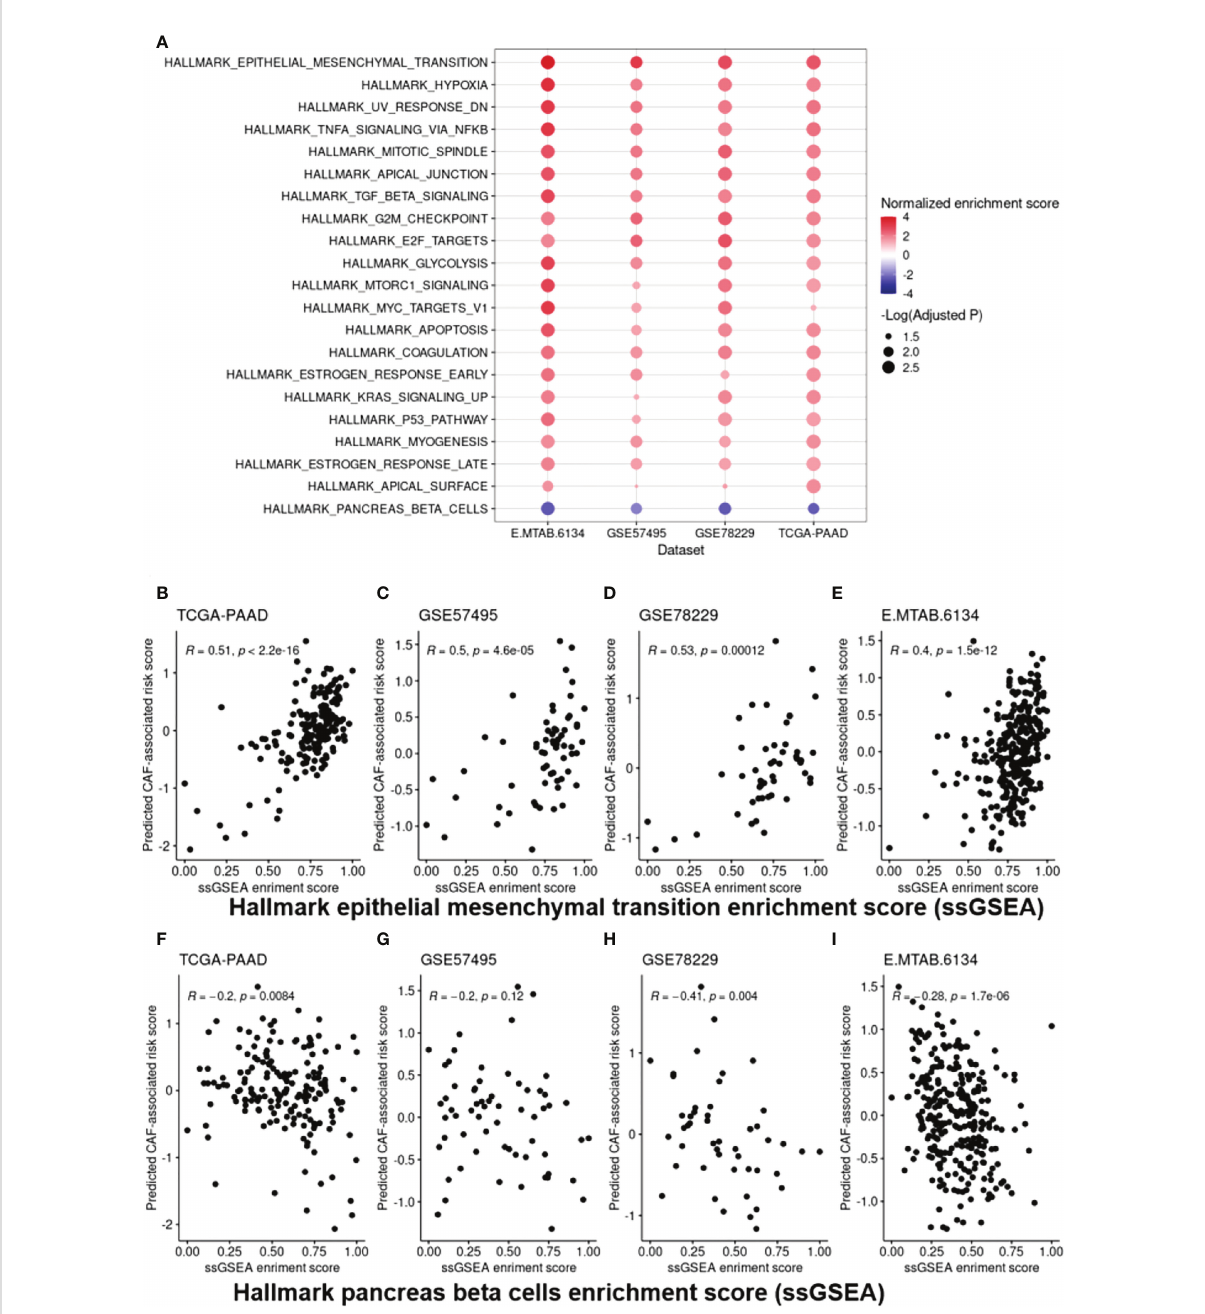
FIGURE 6 Cancer hallmark gene set analysis. (A) , EMT and “ pancreas beta cell ” gene sets were found to be the top dysregulated hallmark gene sets among all the studied datasets. (B-I) , Scatter plots representing the correlation of the CAF-associated risk model with ssGSEA enrichment scores for the EMT (B-E) and “ pancreas beta cell ” gene set (F-I) as a further validation step. EMT, Epithelial-Mesenchymal